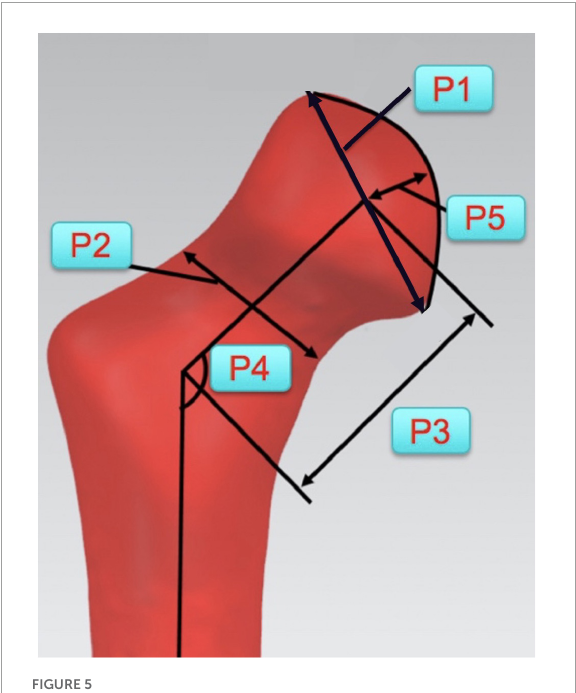
FIGURE5 Key morphological parameters of proximal femur for establishments of average shape model. (P1: Diameter of the femoral head; P2: Diameter of the femoral neck; P3: Length of the femoral neck; P4: Angle between the axes of femoral head and shaft; and P5: Height of the femoral